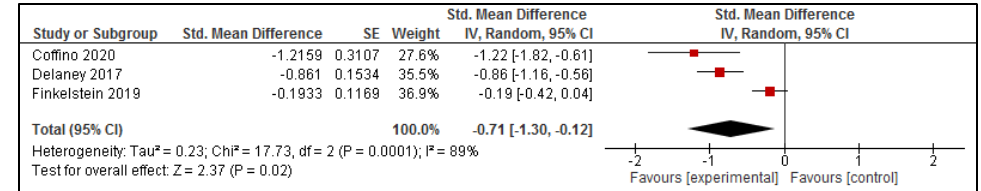
Figure 5. Effect of intervention delivered via online food ordering systems on the Saturated Fat content of purchases.